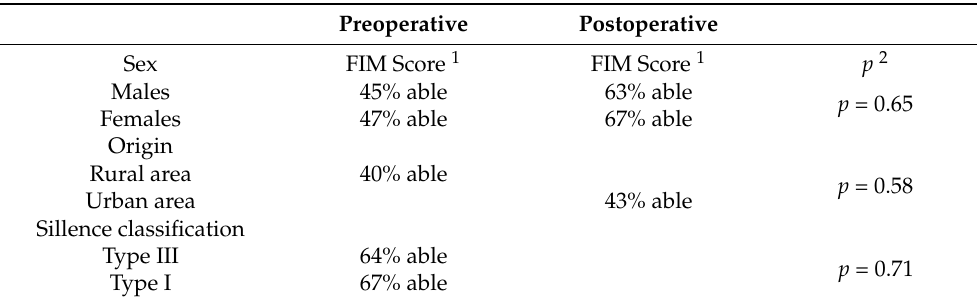
Table 2. Study group abilities based on the FIM questionnaire concerning sex, origin, and Sillence